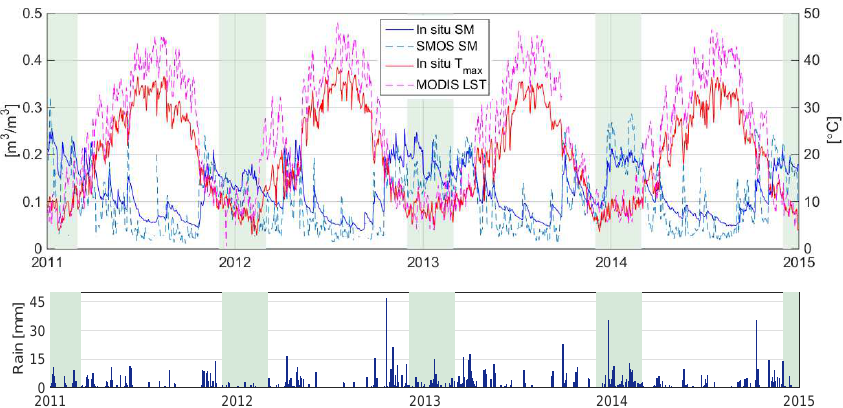
Figure 11. Time-series of in situ SM at the SMOS morning passes and T max ( top ; blue and red solid lines, respectively), SMOS SM at the morning passes and MODIS LST Aqua day ( top ; cyan and magenta dashed lines, respectively), and daily mean precipitation of the REMEDHUS network ( bottom ). Winter seasons (defined as December–January–February, DFJ) are shaded in light green color. Similar behavior is obtained at the afternoon passes and/or using Terra day (not shown).